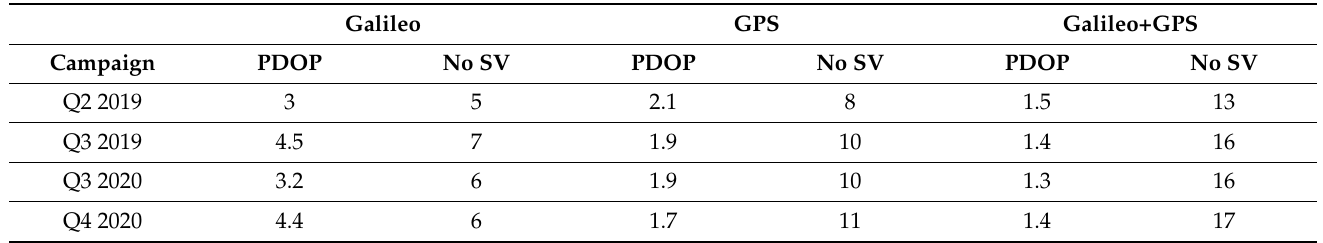
Table 10 presents the maximum number of available satellites and the PDOP average values for each campaign for the Galileo-only, GPS-only, and Galileo+GPS constellations. Table 10. Average PDOP and maximum number of satellites during the maritime data-collection